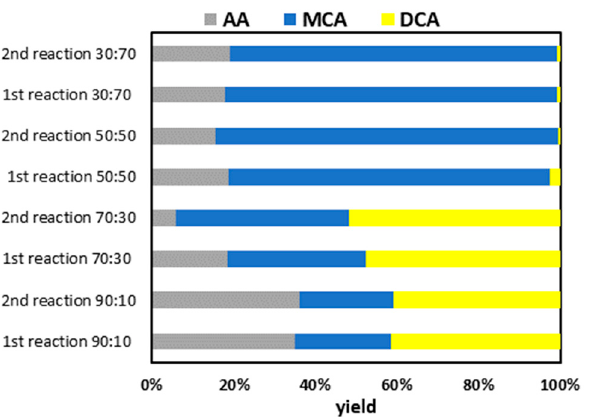
Figure 6. Product distribution after 2 h reaction in TCA reductive dehalogenation of different SilverSil xerogels with NaBH 4 as reducing agent in 6:1 molar ratio in two reaction runs, [TCA] = 1.4 × 10 − 3 M, [BH 4 − ] = 8.4 × 10 − 3 M.